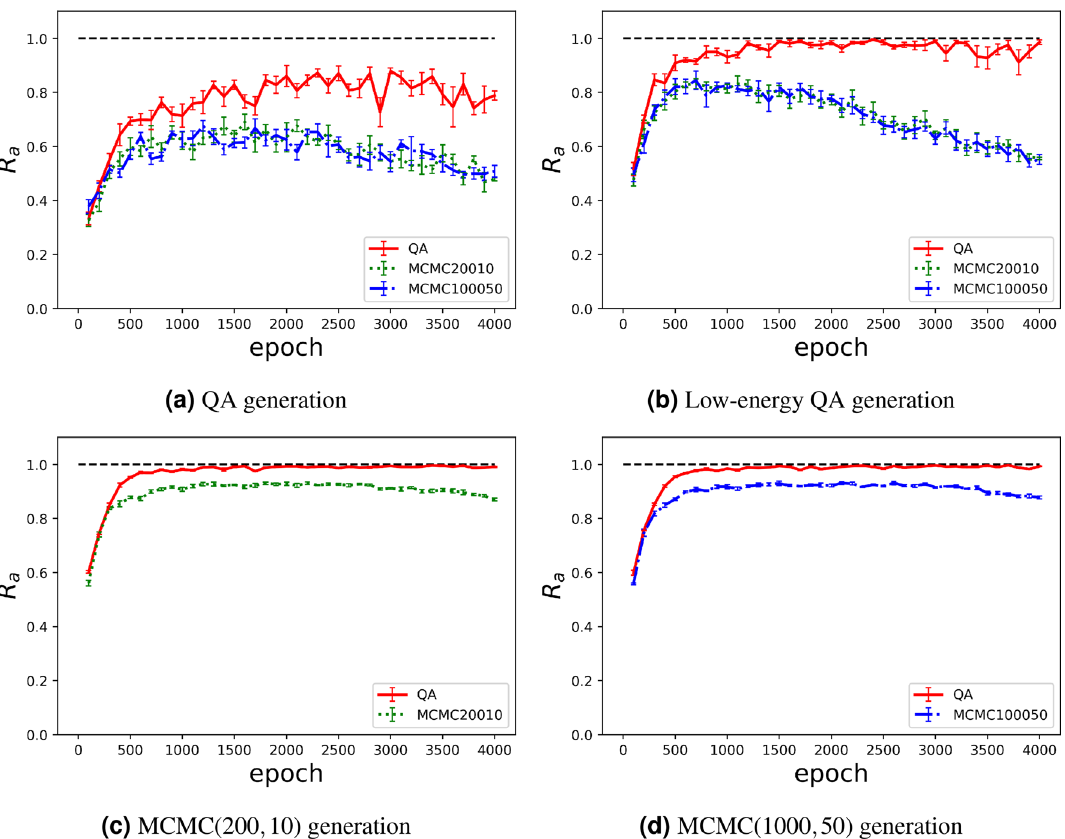
Figure 6. Agreement rate R a over 4000 epochs for different sampling methods for image generation. Training used direct sampling with QA (solid line), MCMC ( T in , � t ) = ( 200, 10 ) (dotted line), and MCMC ( T in , � t ) = ( 1000, 50 ) (dashed-dotted line).